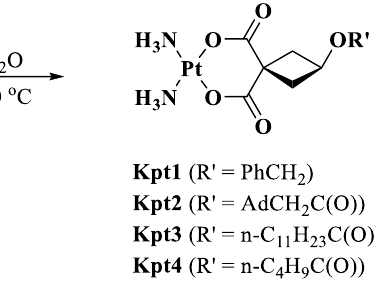
Figure 5. Synthesis of carboplatin derivatives Kpt1-4.